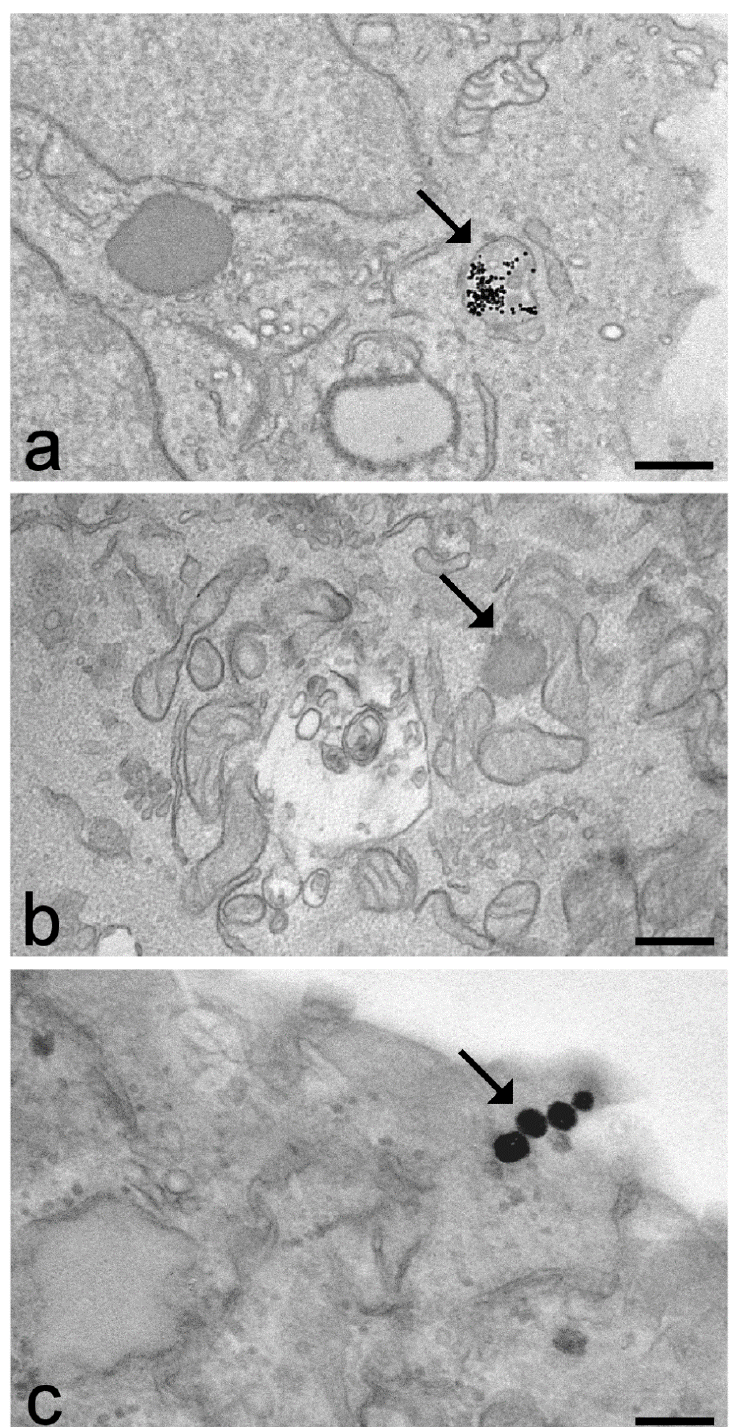
Figure 1. Transmission electron micrographs of cells incubated for 24 h with different types of nanoparticulates (arrows): iron-based nanoparticles in adipose tissue stem cells ( a ), poly(lactic-co-glycolic acid) nanoparticles in C2C12 cells ( b ) and liposomes in HeLa cells ( c ). All cell samples were fixed with aldehydes, post-fixed with osmium tetroxide, embedded in epoxy resin and stained with uranyl acetate to enhance the image contrast. Note the low electron density of the polymeric nanoparticle in ( b ) that makes it hardly detectable in the intracellular milieu. Conversely, the intrinsic electron density of iron ( a ) and the binding of osmium tetroxide to the lipid components of liposomes ( c ) make the particulates in ( a , c ) clearly recognizable inside the cell. Bars: 200 nm.